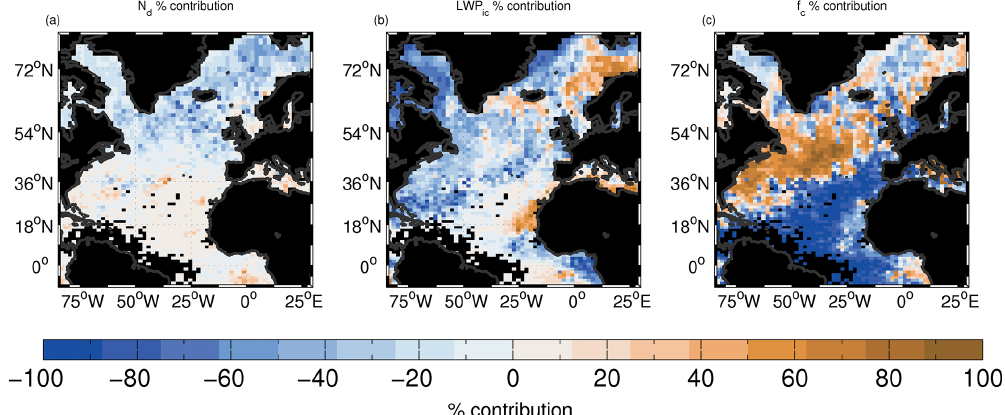
Figure 11. The percentage of the sum of the absolute biases contributed by the biases in N d (a) , LWP ic (b) and f c (c) . See Eq. (3). Note that the absolute values of the percentages for each grid box add up to